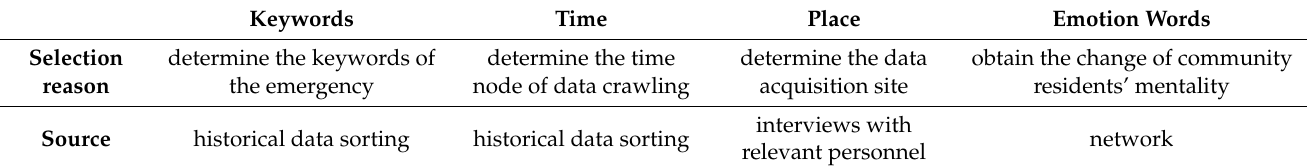
Table 1. Key data of relevant web pages and